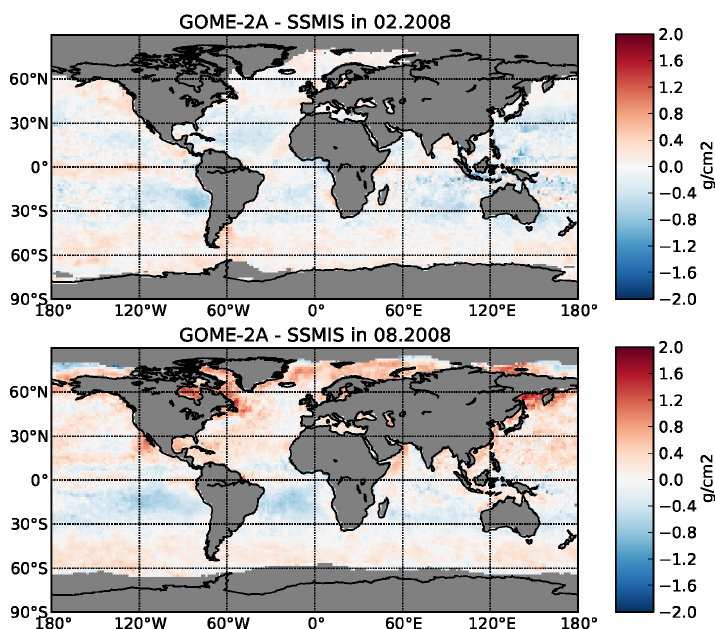
Figure 12. Geographical distribution of the differences between GOME-2A and SSMIS total column water vapour in February 2008 (top panel) and August 2008 (bottom panel). Only cloud-screened co-located data have been